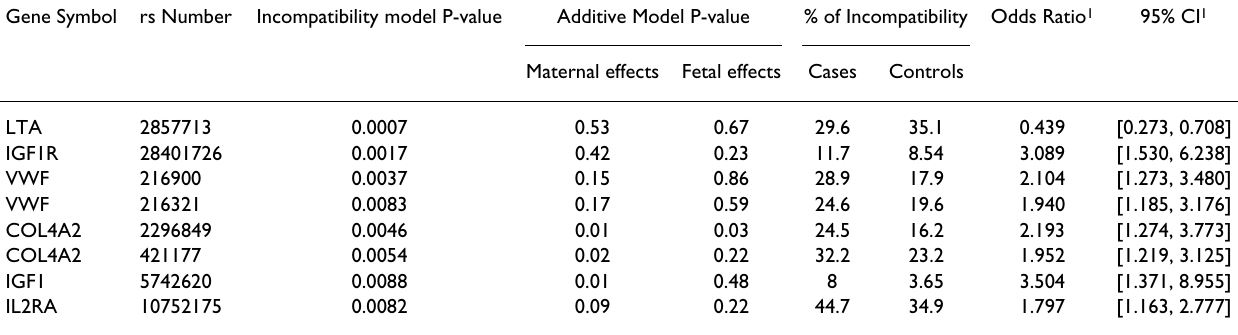
Table 3: Genes in which a SNP has a p-value < 0.01 for the maternal-fetal incompatibility model in the pre-eclampsia dataset Gene Symbol rs Number Incompatibility model